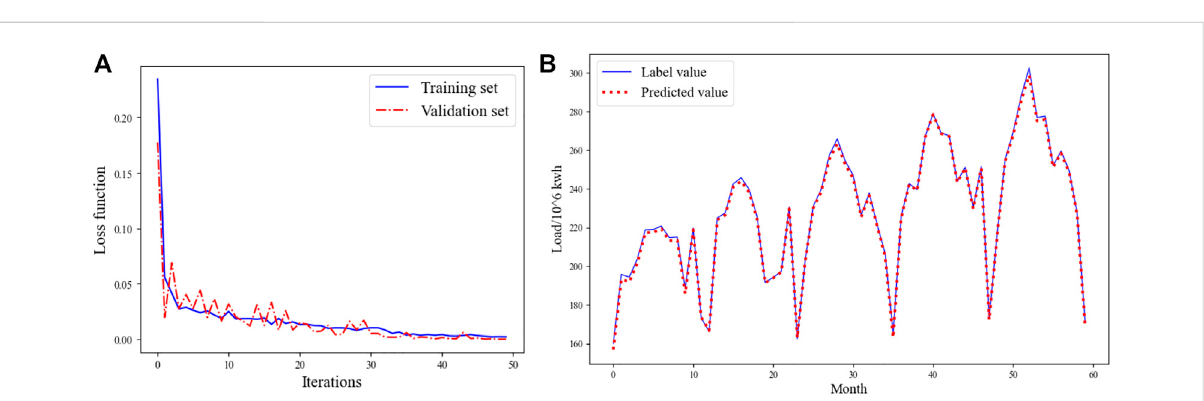
FIGURE 5 The result of pharmaceutical manufacturing industry load forecasting: (A) loss function curve, (B) comparison curve between the predicted value and the label